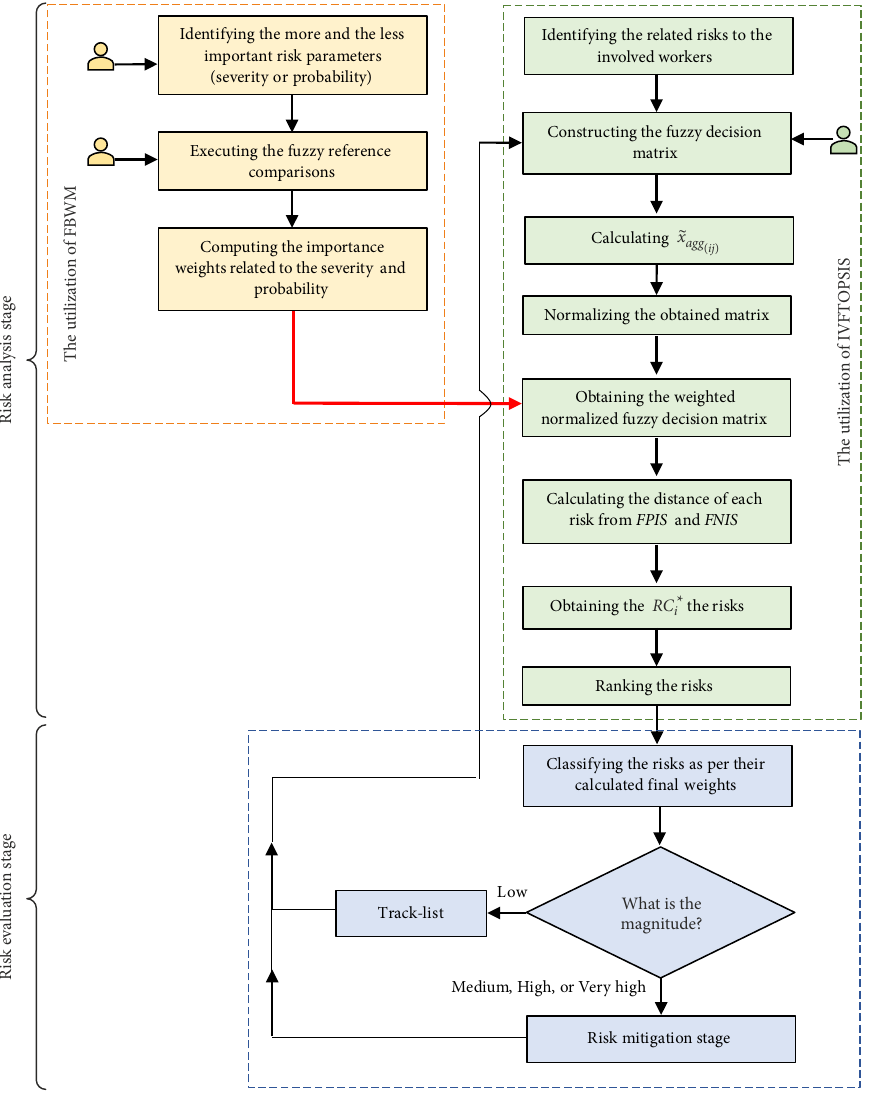
Figure 1. The developed RAM